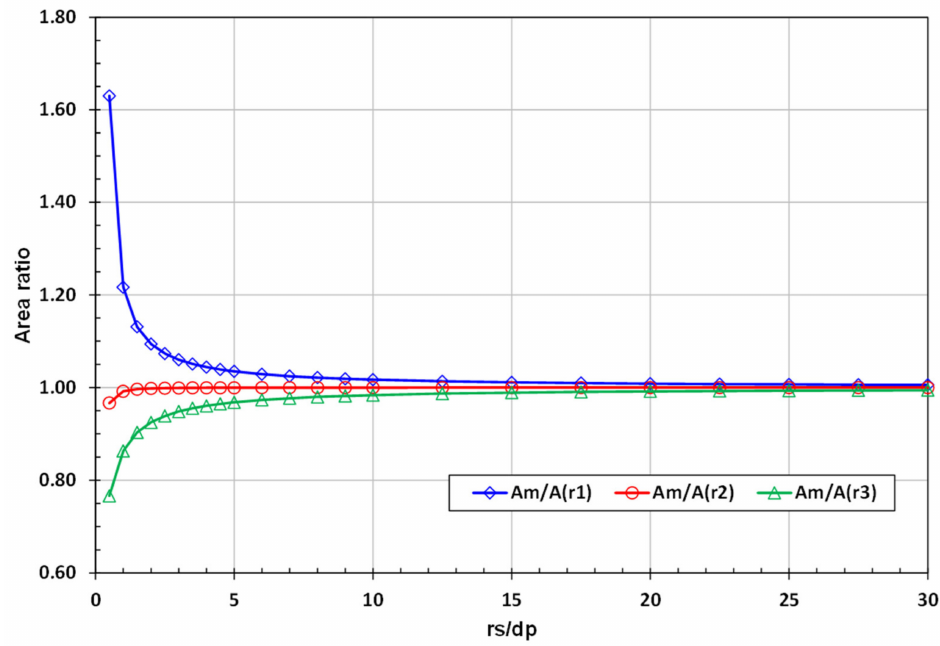
Figure 3. Results of the analysis of asymptotic behavior of Equation (17) for r p ≤ r s ≤ 30 r p